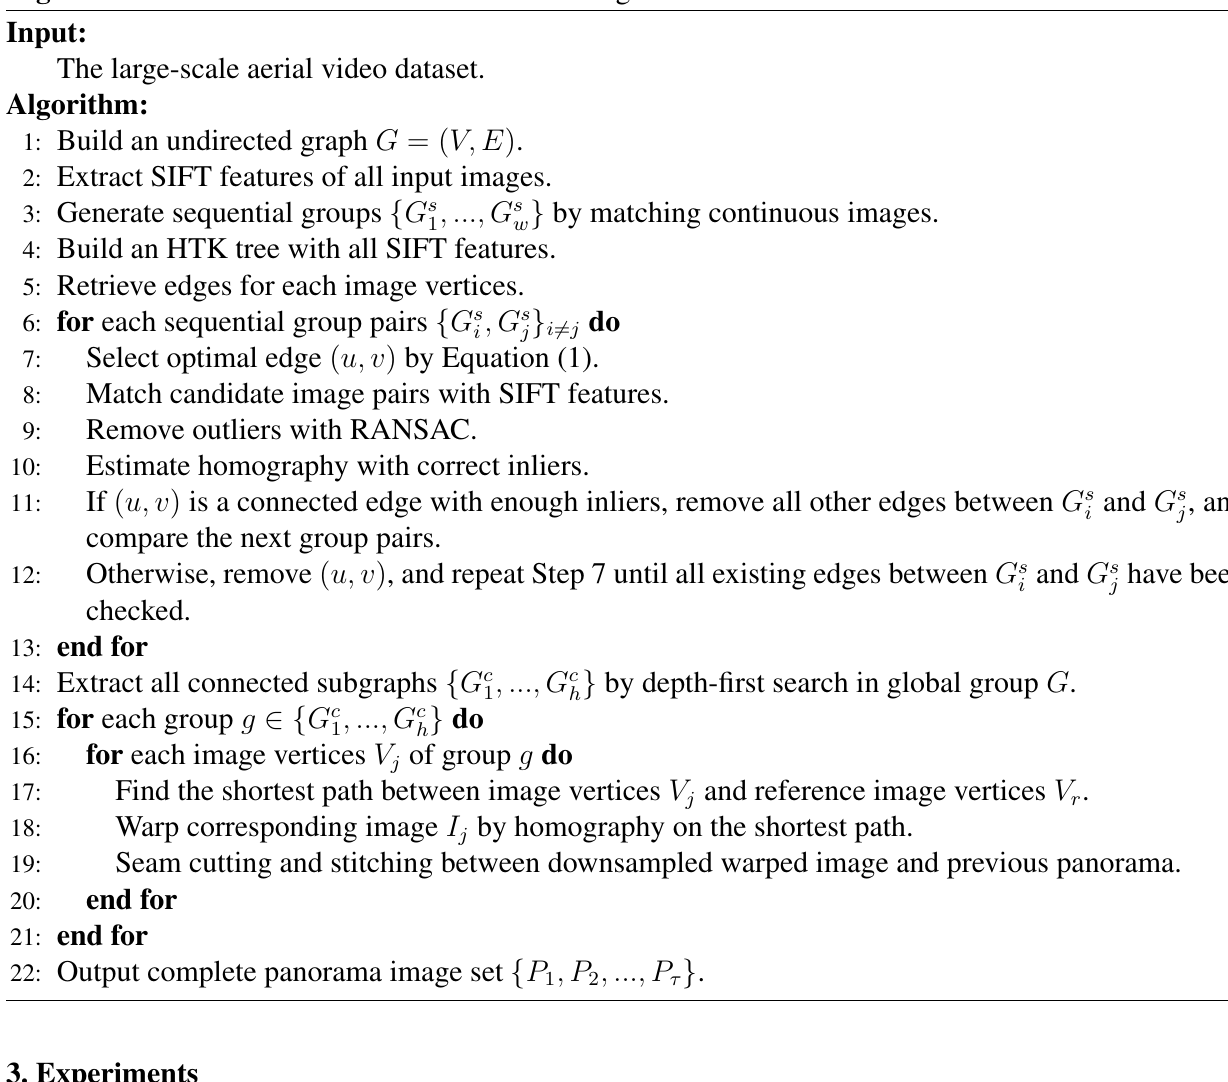
Algorithm 1 Pseudocode for diverse scene